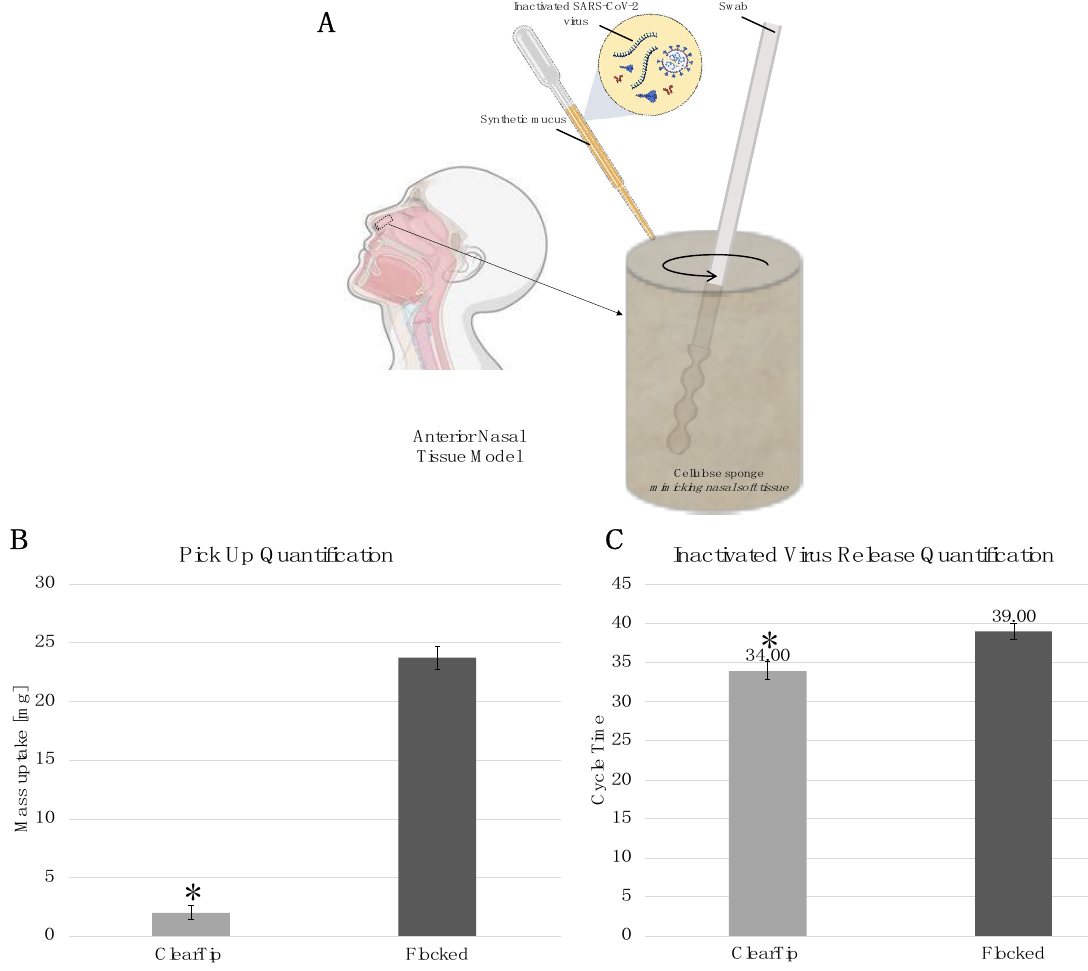
Figure 2. ClearTip TM benchtop validation. ( A ) Anterior nasal tissue model comprising a cellulose sponge loaded with synthetic nasal mucus spiked with inactivated SARS-CoV-2. The cellulose sponge mimicked the nasal soft tissue during the benchtop swabbing procedure with the ClearTip TM in comparison to flocked control swab. ( B ) Mass uptake during the benchtop swabbing procedure was quantified by gravimetrical analysis. Flocked control samples displayed a statistically greater mass update compared with ClearTip TM . ( C ) Swab material release was collected into viral transport media, and inactivated virus was quantified using PCR following CDC guidelines. * Statistical difference against flocked control group ( p < 0.05). Created with BioRender.com (Accessed on 9 January 2021).